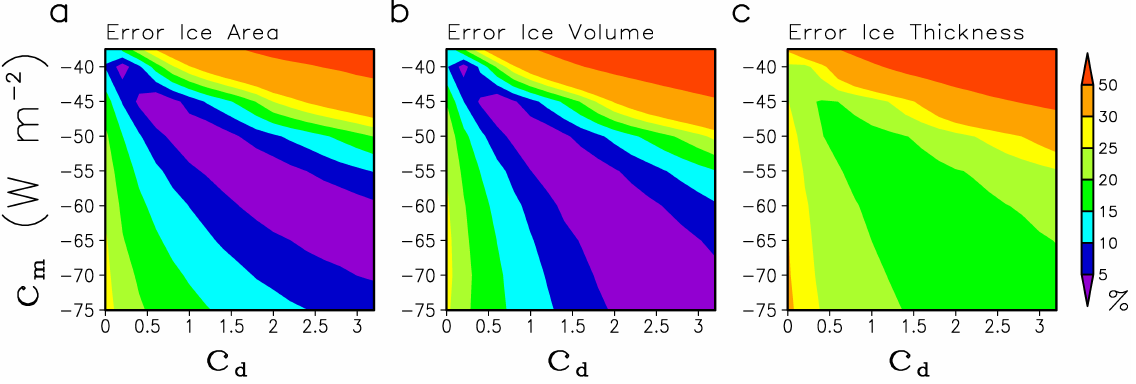
Figure 4. Error measures for a modelled ice sheet in the { c d }×{ c m } parameter space. Relative errors in (a) ice area, (b) ice volume and (c) ice thickness, all in